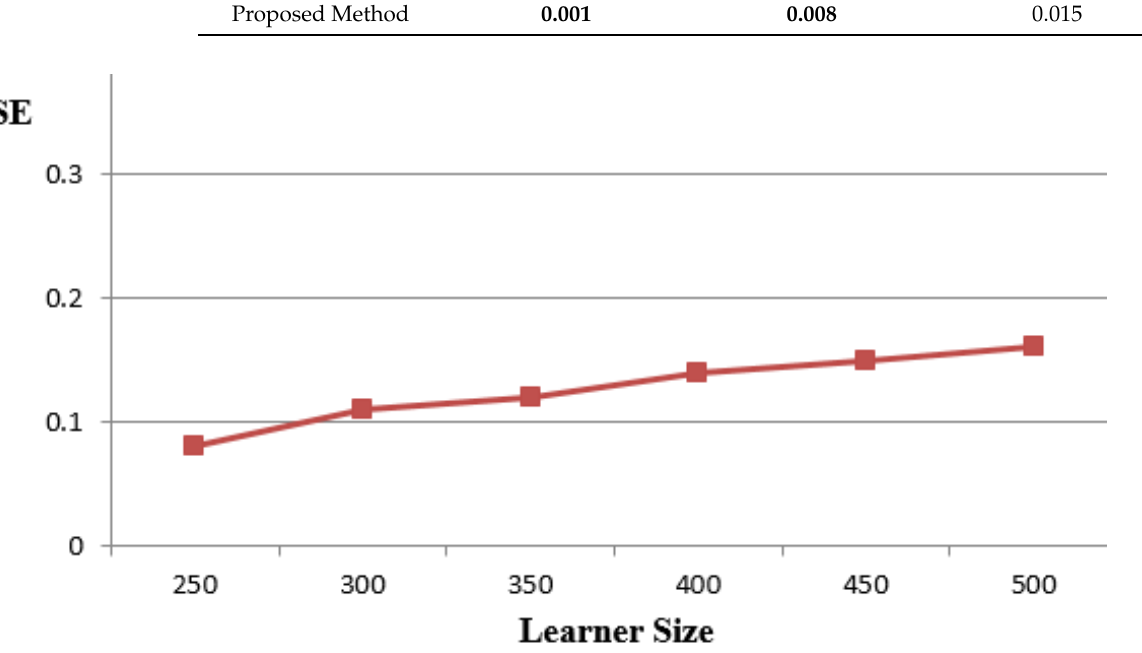
Figure 7. RMSE for different learner group sizes.